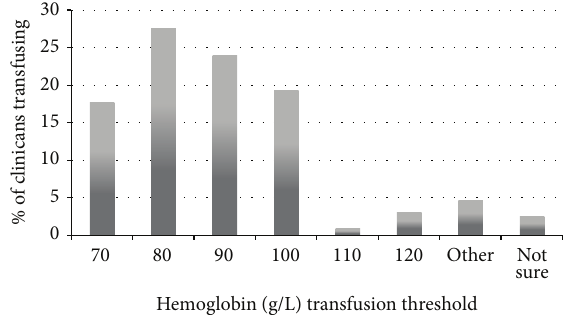
Figure 2: Selected hemoglobin transfusion thresholds for a healthy and hemodynamically unstable patient with UGIB as described in Scenario 2.